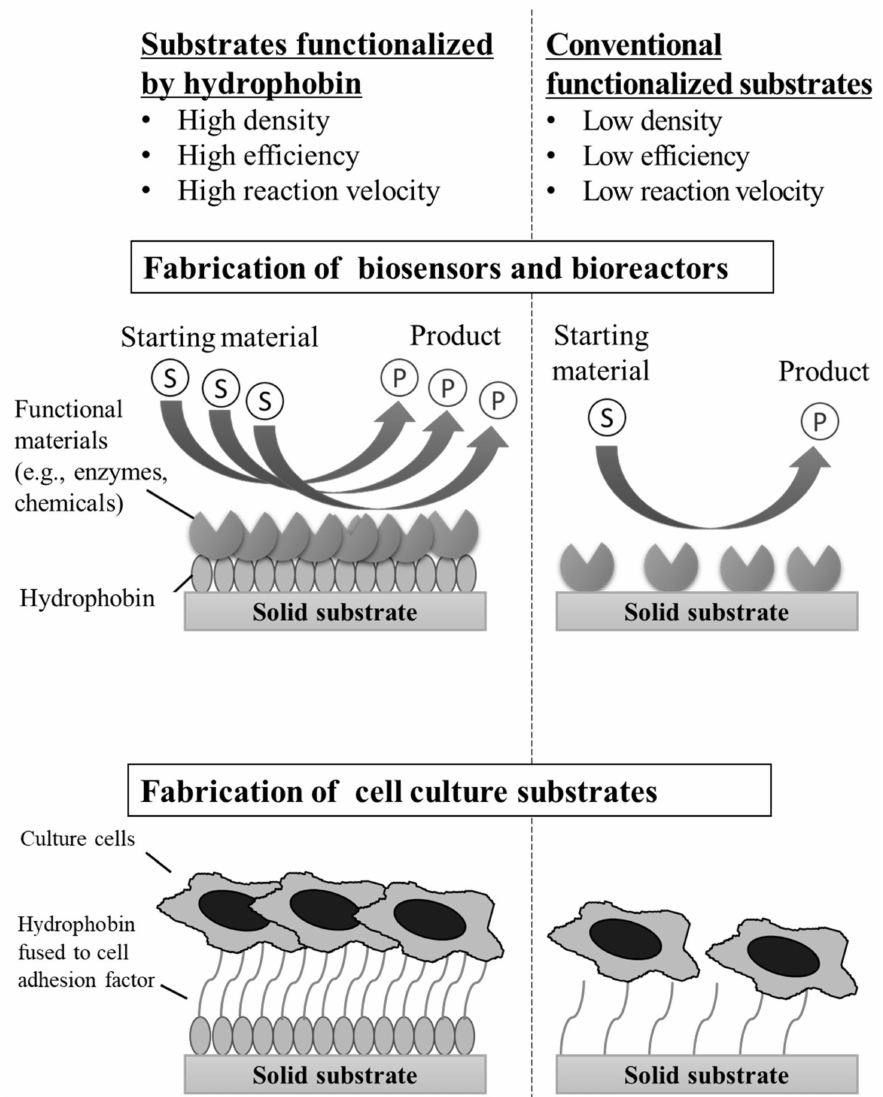
Figure 7. Schematic diagram of hypothetical applications of hydrophobins: fabrication of biosensors, cell culture substrates, and bioreactors for material degradation or conversion. Left part of each panel: solid substrates functionalized by hydrophobins. Right part of each panel: conventional functionalized substrates in which functional materials are immobilized on the solid surface via a chemical